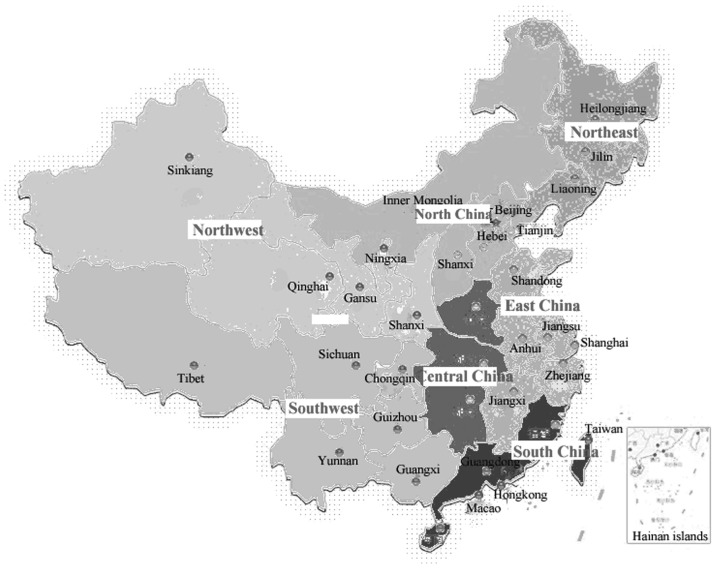
Regional distribution of the patients with HCV recruited in this study. Twenty-eight hospitals were divided territorially into North, Northeast, Southwest, South, Central, Northwest and East China. There were 92 HCV-infected patients in North China, 91 in Southwest China, 104 in South China, 224 in Central China, 162 in Northwest China, 252 in East China and 89 in Northeast China. HCV, hepatitis C virus.